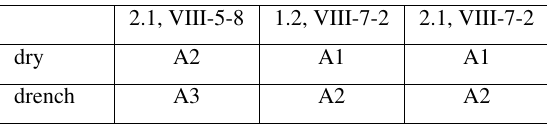
Table 2. Differences of shades on dry and saturated samples